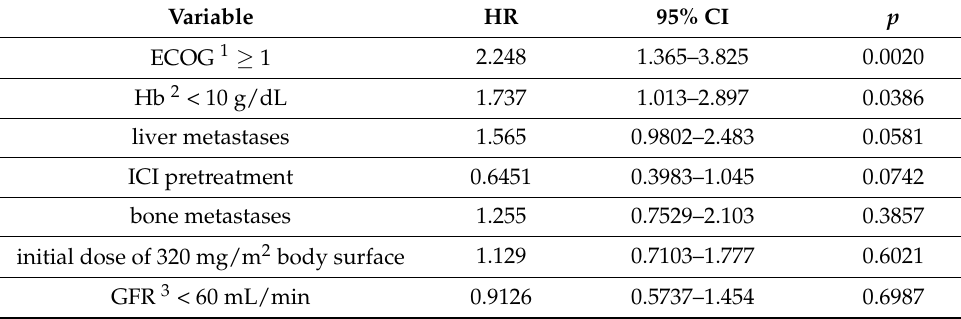
Table 6. Multivariable Cox regression analyses of OS in all